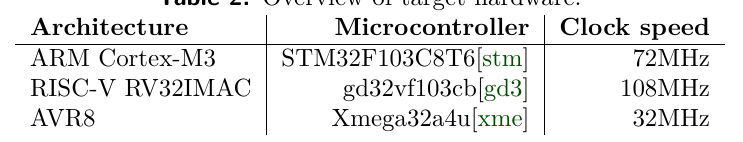
Table 2: Overview of target